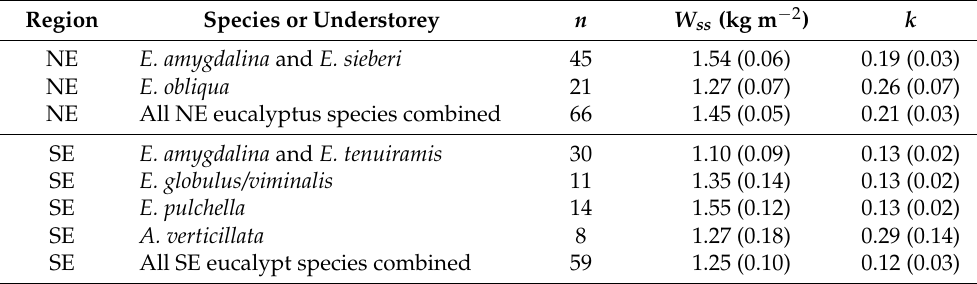
Table 5. Goodness-of-fit statistics for surface/near-surface fuel load models. Figure 4. Modelled surface/near-surface fuel load accumulation curves (solid lines) with confidence bands (dotted lines) and prediction bands for new sites (dashed lines). ( a ) NE sites; ( b ) SE sites.